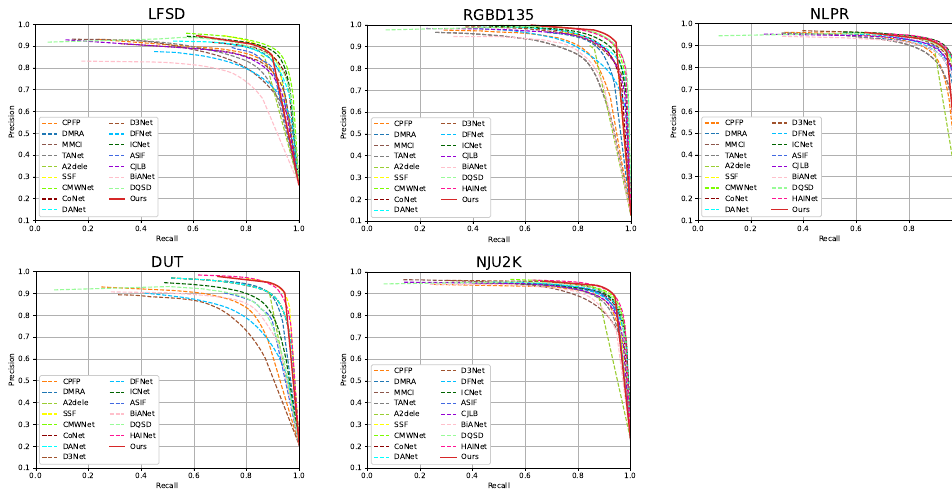
Figure 6. Precision–Recall curves of the proposed model and other salient object detection methods on LFSD [37], NLPR [38], DUT [39], NJU2K [40], and RGBD135 [40]